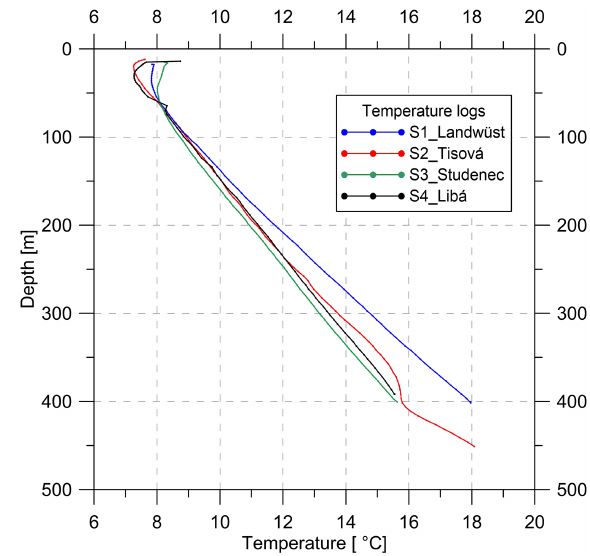
Figure 11. Temperature logs of the individual